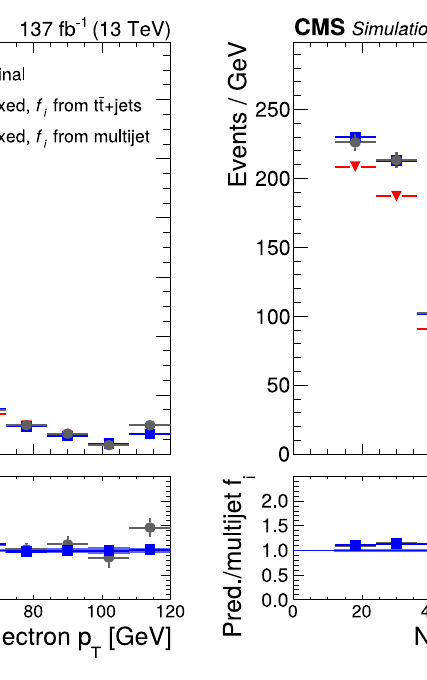
discussed in text. The figure illustrates that a nonclosure correction needs to be applied to the probabilities f i measured for electrons in data, while no such correction is needed for